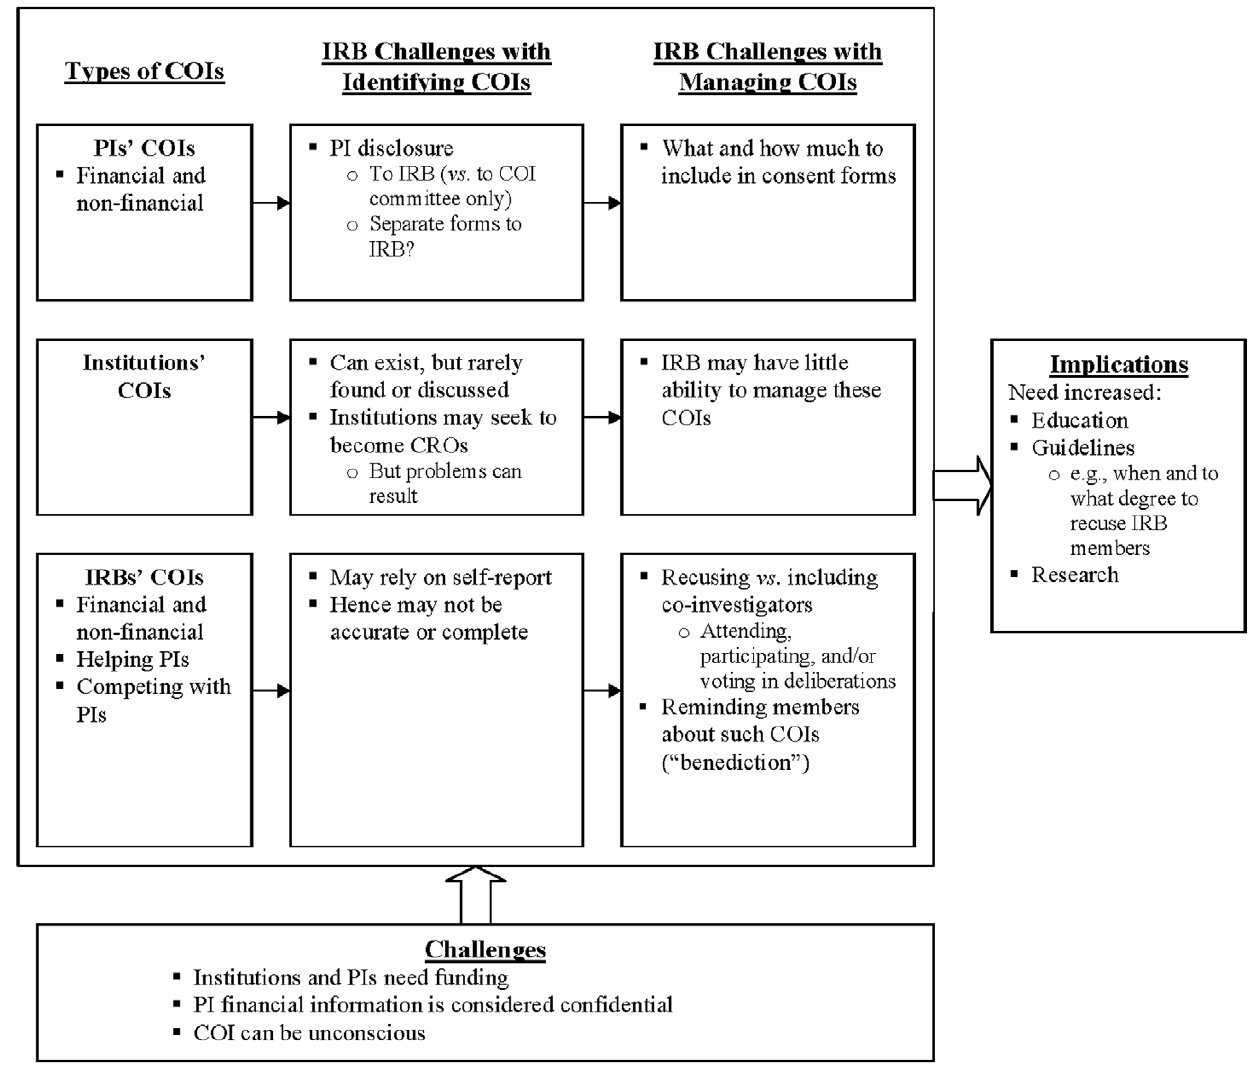
Figure 1. Issues Concerning Identification and Manage of IRBs’ Own and Others’ COIs.